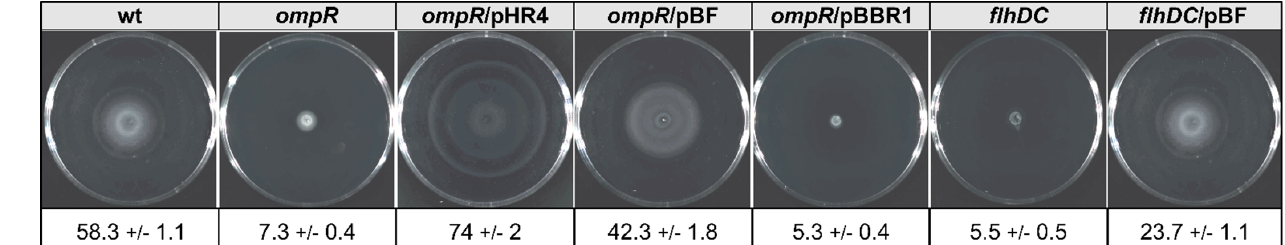
Figure 8. OmpR and FlhDC regulators are required for Y. enterocolitica swimming motility. Swim- ming zones were observed on 0.3% TB0 agar plates after 18 h incubation at 25 °C. Average swim- ming halo diameters (mm) and standard deviations are